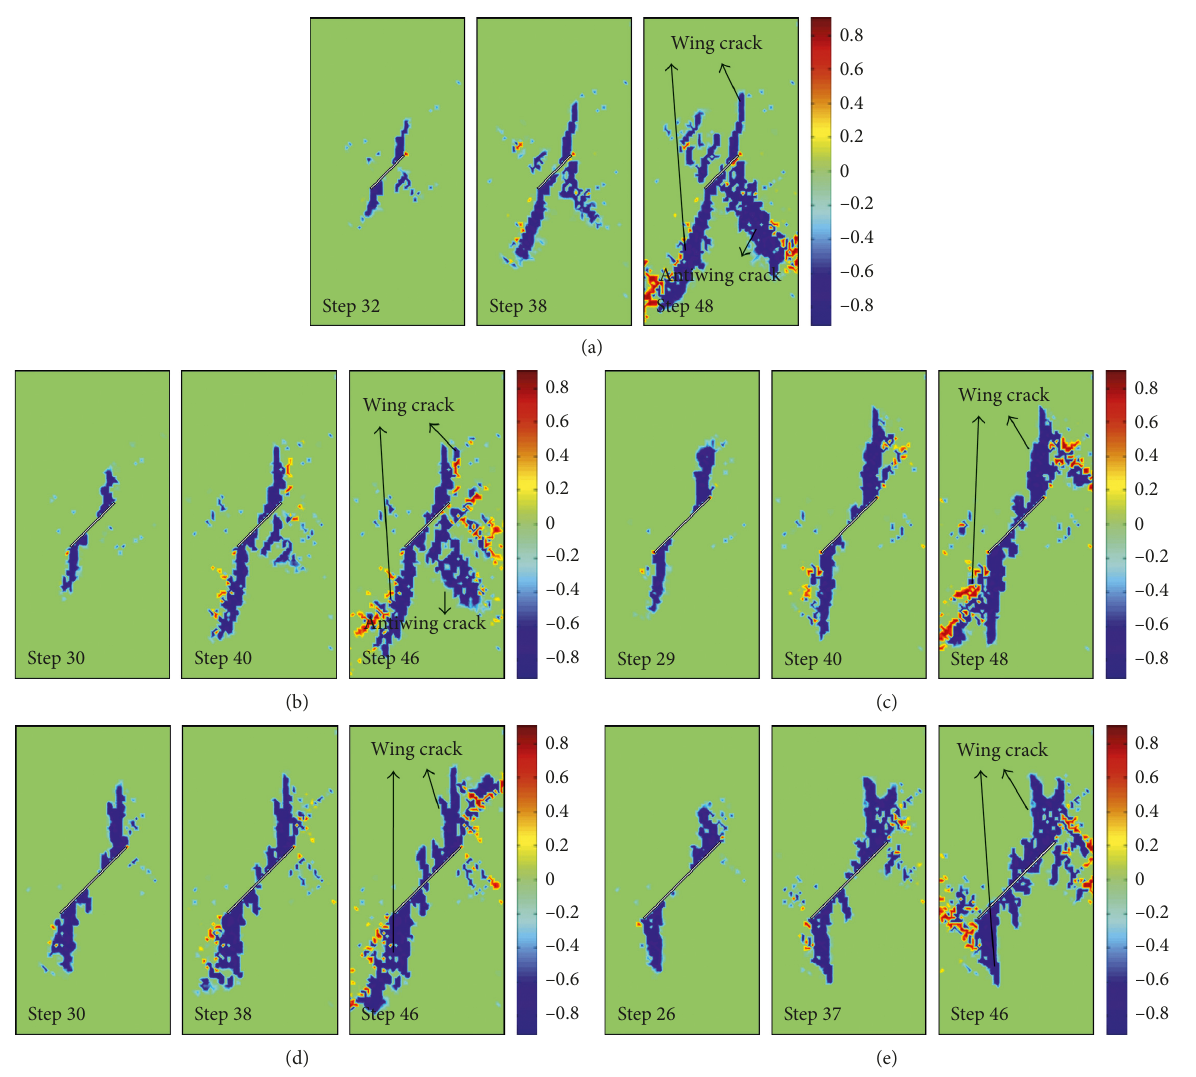
Figure 14: Damage evolution of samples under uniaxial compression tests with various lengths (2 a ) of preexisting fracture. (a) 2 a (b) 2 a 20mm; (c) 2 a 25mm; (d) 2 a 30mm; (e) 2 a (cid:30) (cid:30) (cid:30) (cid:30)